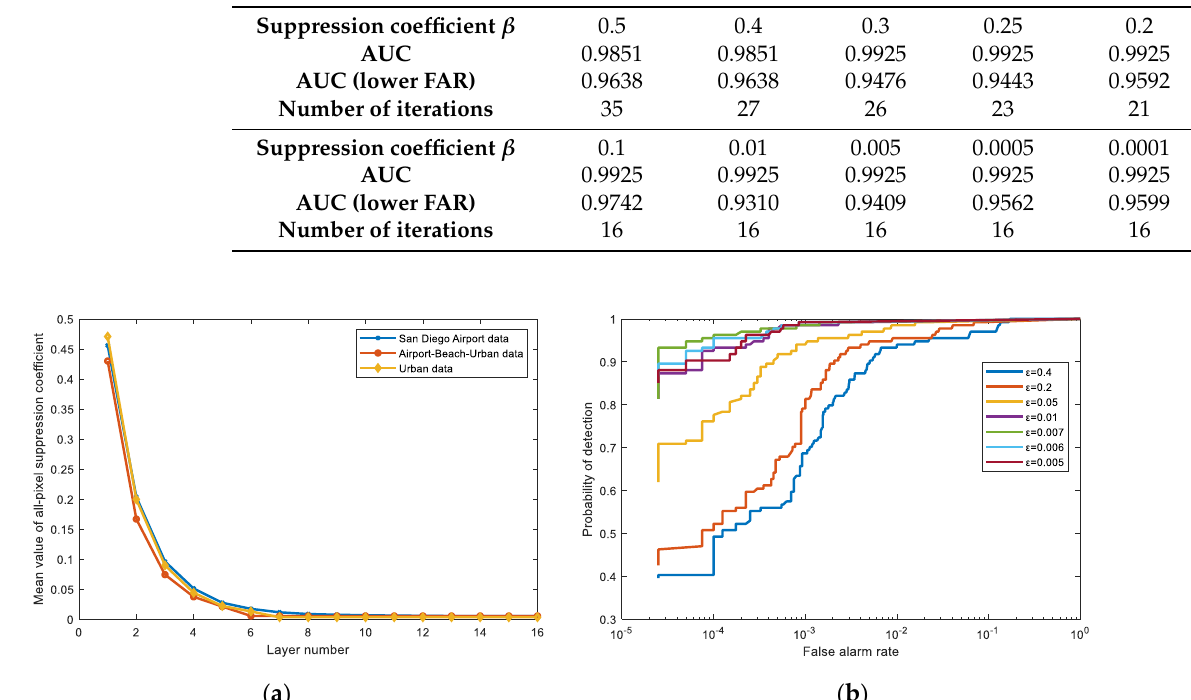
Table 5. The number of iterations and detection performance for different β values.